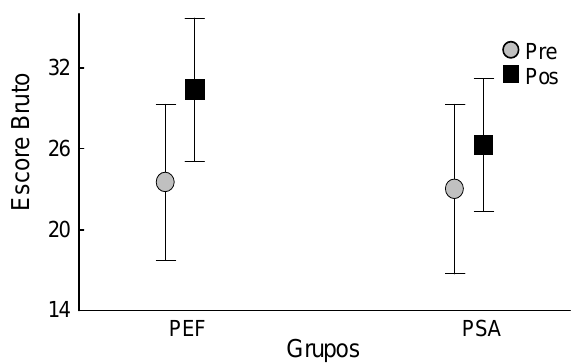
Figura 1. Média e desvio-padrão dos valores brutos para o subteste locomotor das crianças sem educação física (SEF) e com educação física (CEF), no pré- e pós-teste.